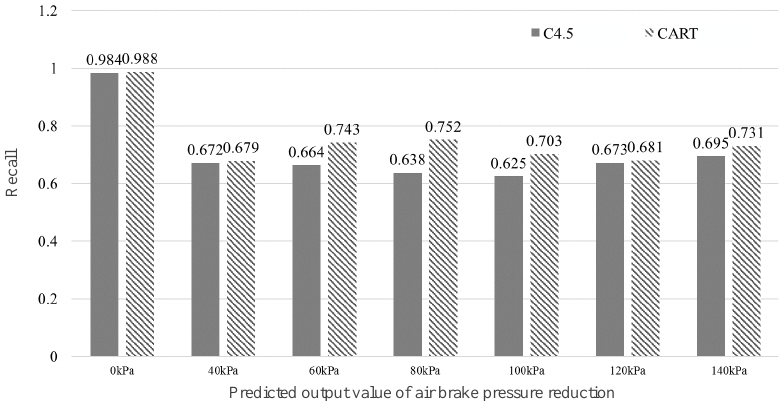
Figure 7. Prediction recall of C4.5 and CART